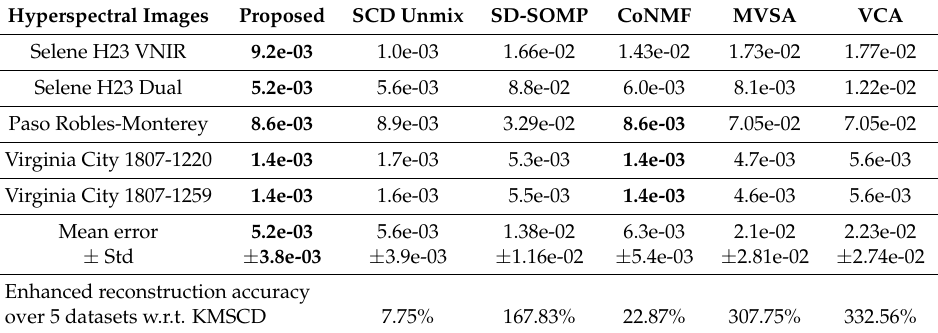
Table 4. Mean Manhattan distance error per band on various hyperspectral